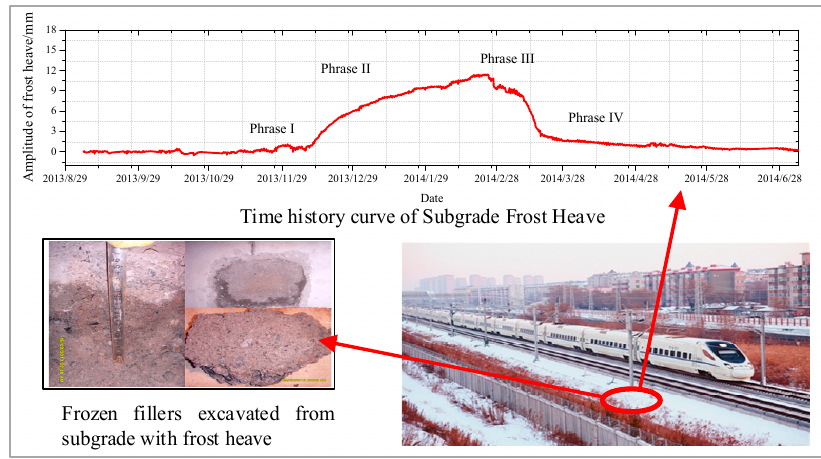
Figure 1. Subgrade frost heave caused by frozen fillers in Harbin-Dalian high-speed railway.